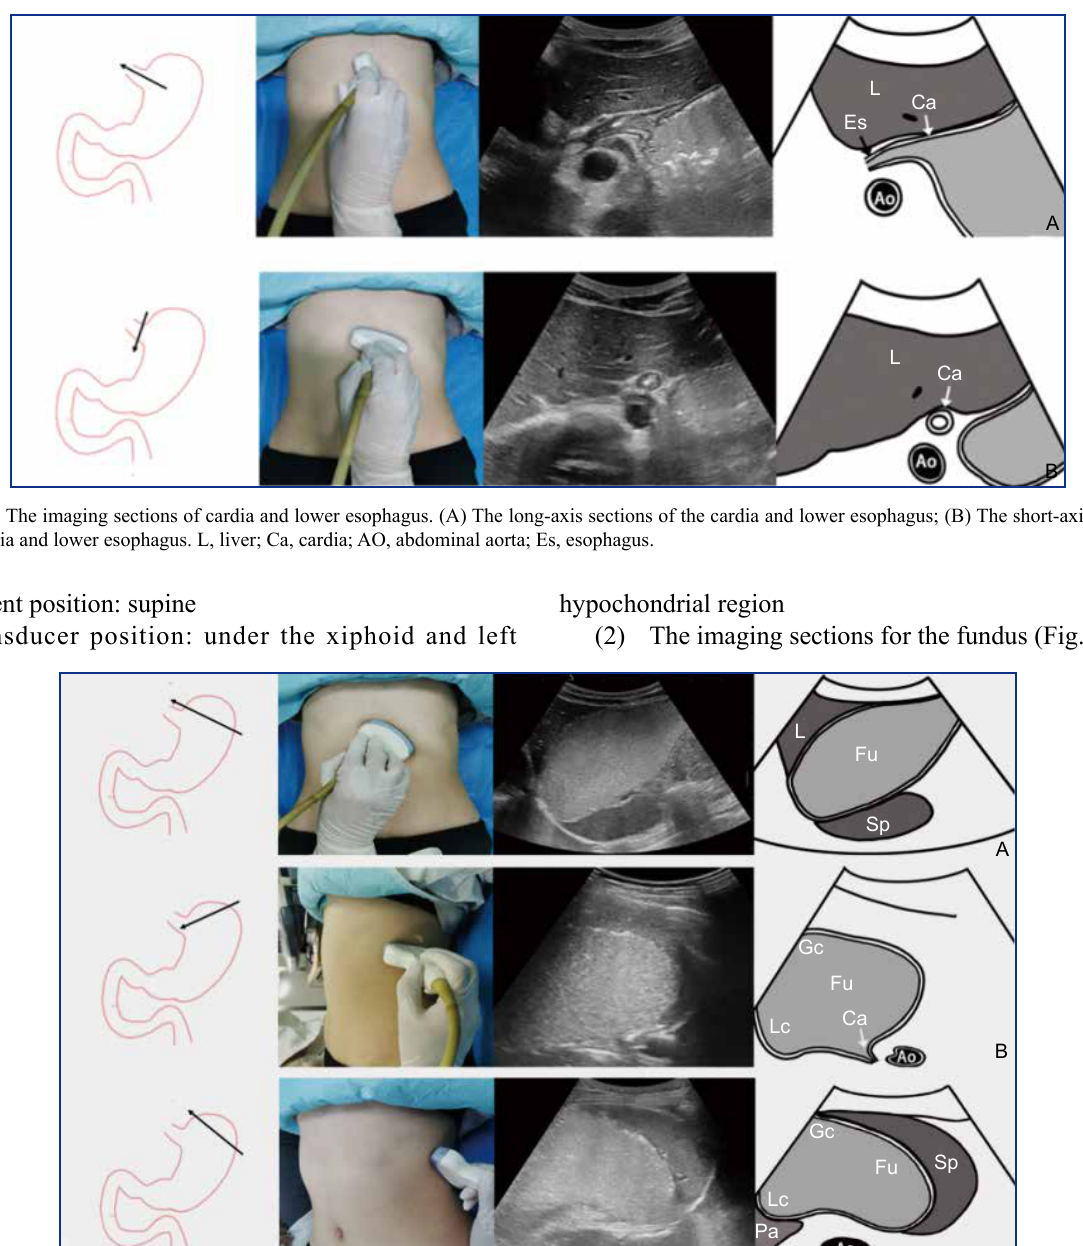
Figure 1 The five layers’ structure of normal gastric wall